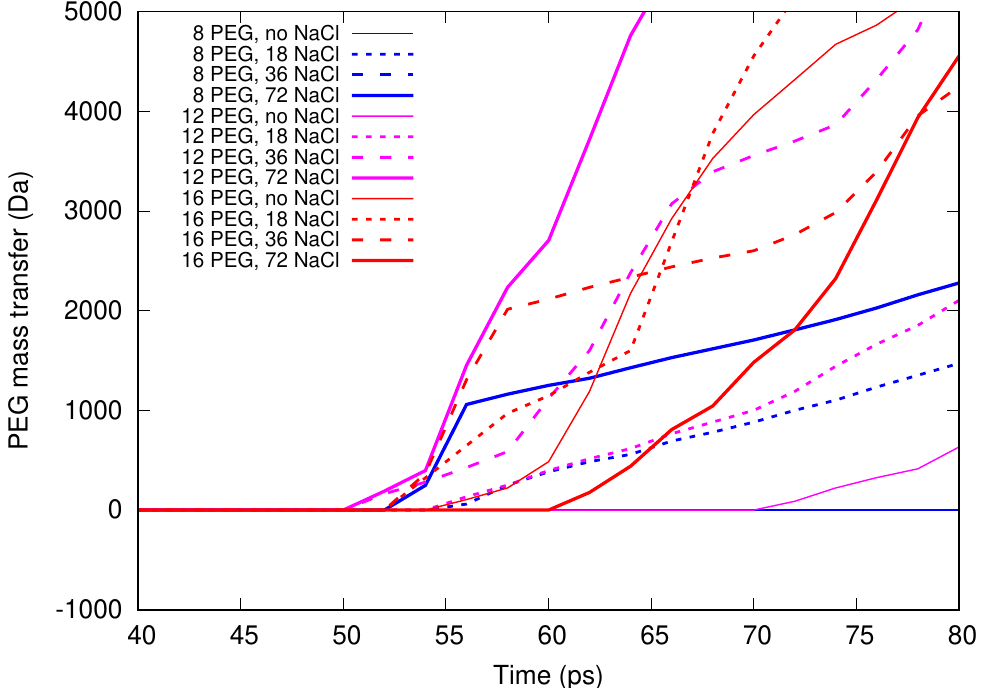
Figure 13. Mass of PEG transported through the plane at z = 20 nm as a function of production time for samples with 5.26-kDa PEG chains under 1.5 V/nm. Curves correspond to different numbers of 5.26-kDa PEG chains and NaCl ion pairs, see the legend. Plotted with gnuplot